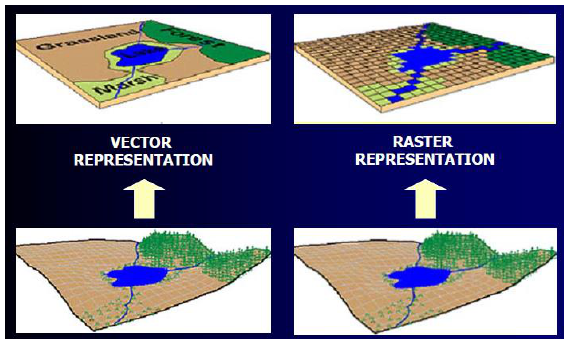
Figure 3: Comparison nature and presentation of vector and raster spatial model.